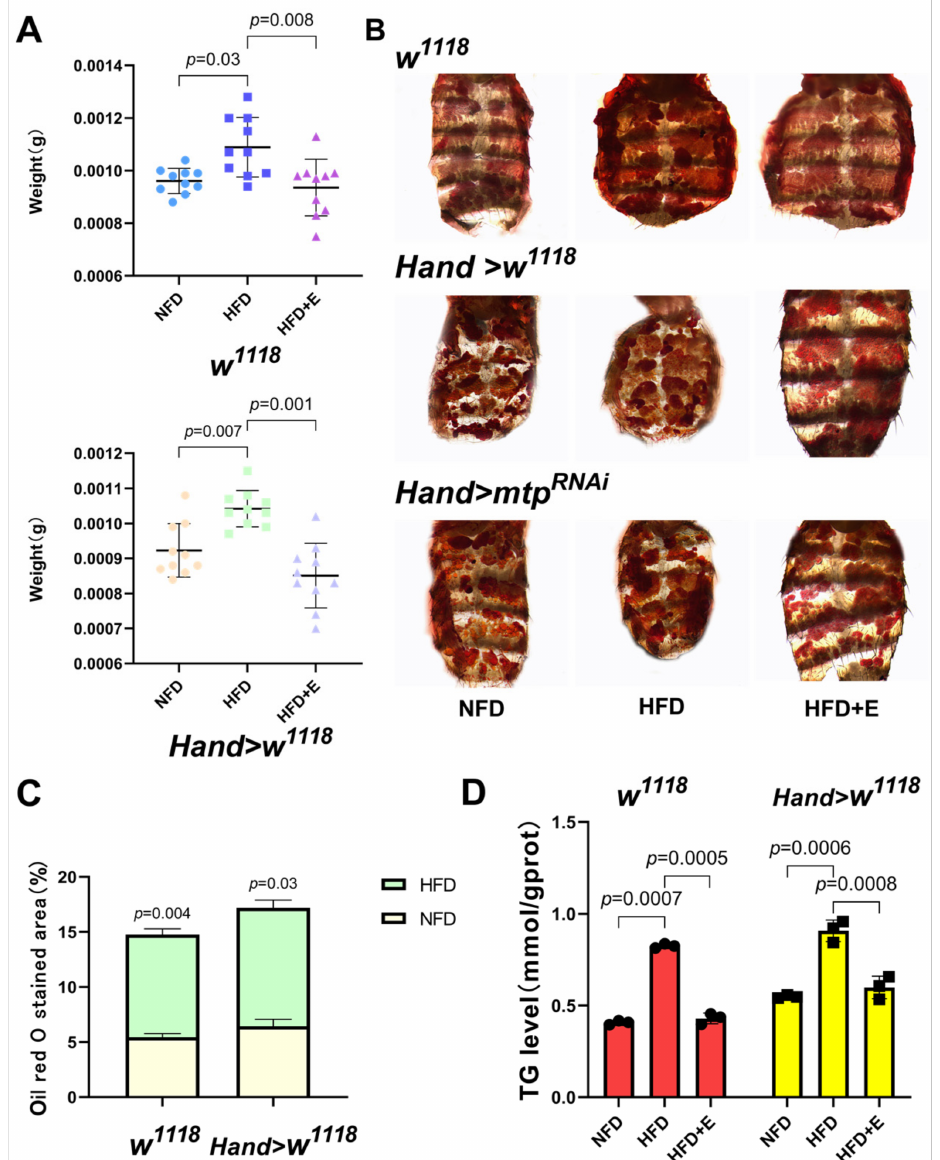
Figure 2. ( A ) Body weights were obtained by weighing the 10-day-old flies on an electronic microbal- ance, N = 10, with a significant increase in body weight in Drosophila after HFD feeding compared to the NFD group but a decrease in body weight after the exercise intervention. ( B ) ORO abdominal staining of each group of the 10-day-old flies under different treatment conditions. ( C ) ORO staining in the abdomen of Drosophila . N = 5. The area of ORO staining in the abdomen of Drosophila was larger in the HFD group compared to the NFD group. ( D ) Whole-body TG levels in 10-day-old Drosophila . Whole-body TG levels were significantly higher in the HFD group than in the NFD group. N = 10, repeated three times. One-way ANOVA was used for ( A , D ). An independent sample t -test was used for ( C